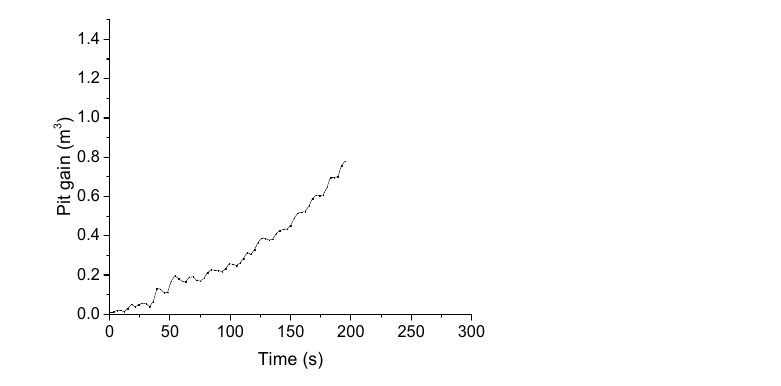
Figure 11. Time sequence diagram of pit gain.